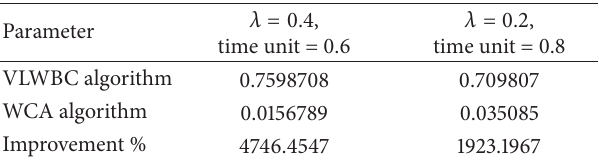
Table 7: VLWBC availability improvement compared to